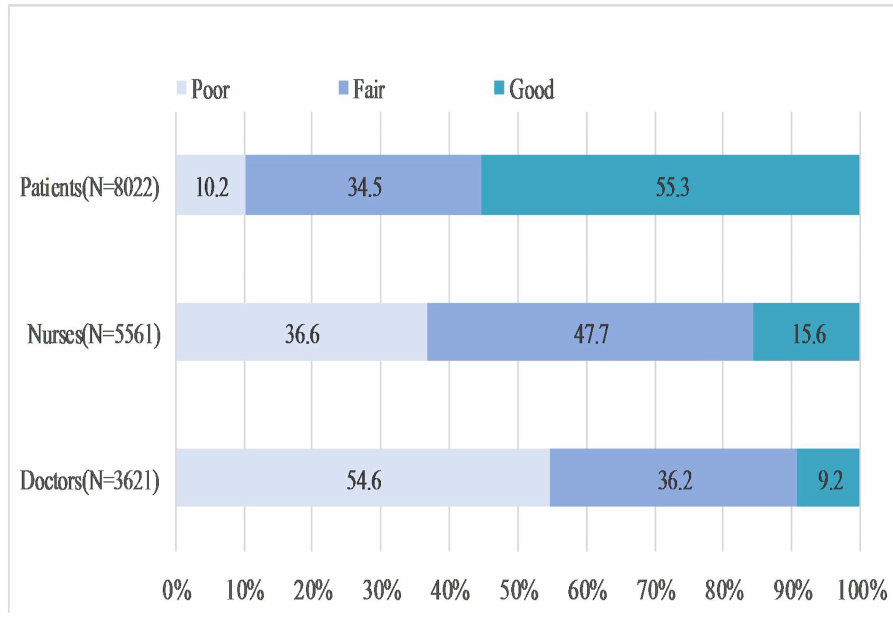
Fig 2. The proportion of the perception of PPR of doctors, nurses and patients.